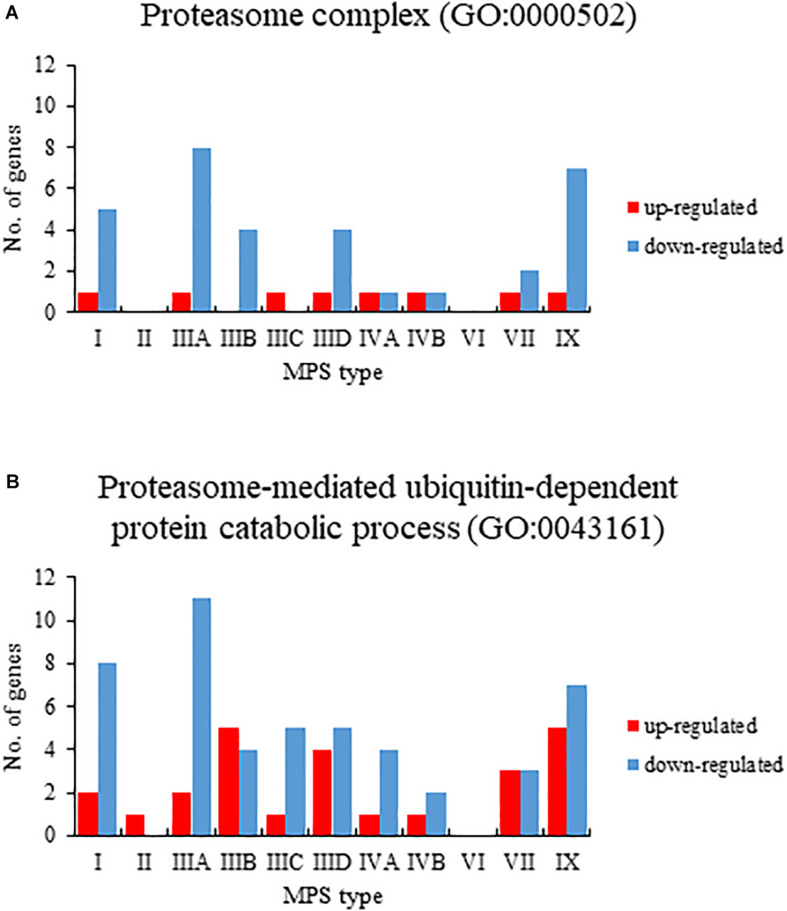
Number of up (red)- and down (blue)-regulated transcripts (at FDR < 0.1; p < 0.1), grouped in GO terms proteasome complex (GO:0000502) (A) and proteasome-mediated ubiquitin-dependent protein catabolic process (GO:0043161) (B), in different types of MPS relative to control cells (HDFa), as revealed by transcriptomic (RNA-seq) analyses.